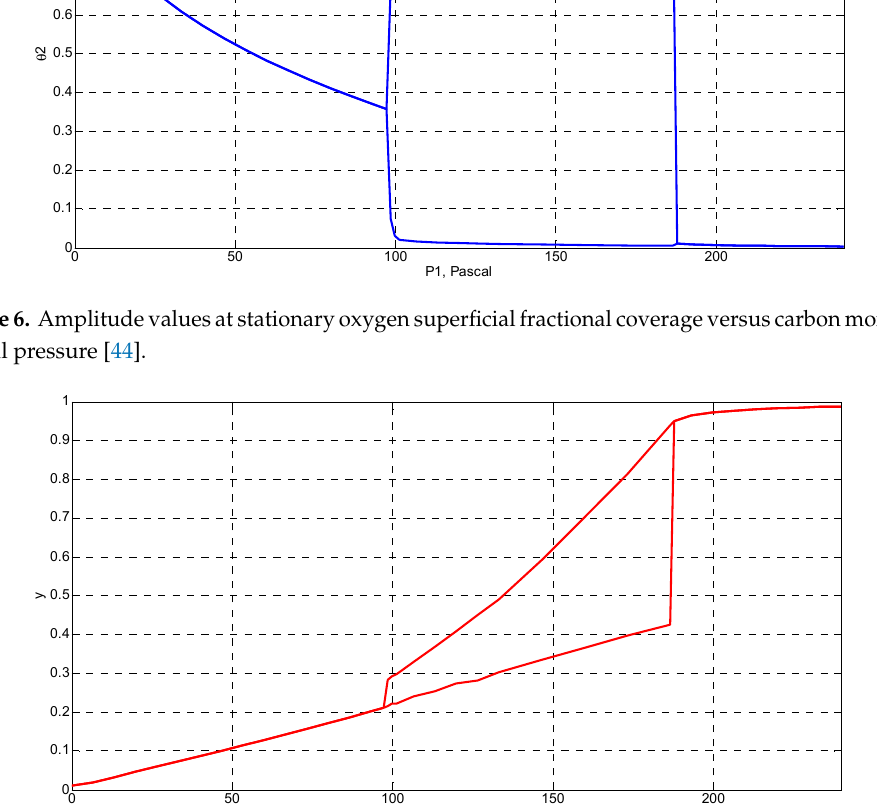
Figure 7. Amplitude values at stationary superficial density versus carbon monoxide partial pressure [44].